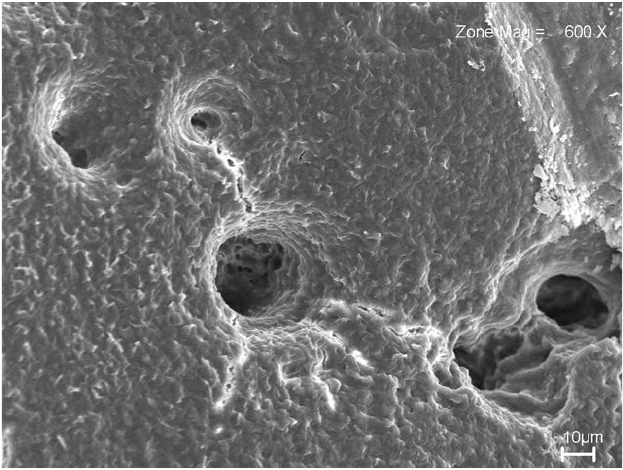
Fig. 2. SEM micrograph of foramina in the furcation region (Original magnification